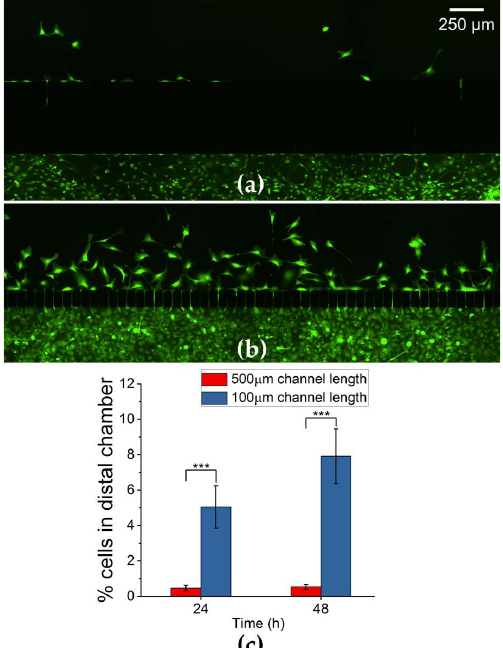
Figure 5. Primary myoblast cells subjected to microchannel lengths of 100 µm and 500 µm (width = 5 µm) exhibit length dependent constriction across microchannels. ( a ) Representative fluorescent image of myoblast cells across 500 µm microchannel length after 24 h. ( b ) Representative fluorescent image of myoblast cells in the across 100 µm microchannel length. ( c ) Plot of the percentage cells in distal chamber after 24 and 48 h of migration in devices with microchannel length 100 µm and 500 µm. Black asterisks are used to denote statistically significant differences (*p < 0.05, **p < 0.01, ***p < 0.001) and error bars represent standard error of the mean (SEM).